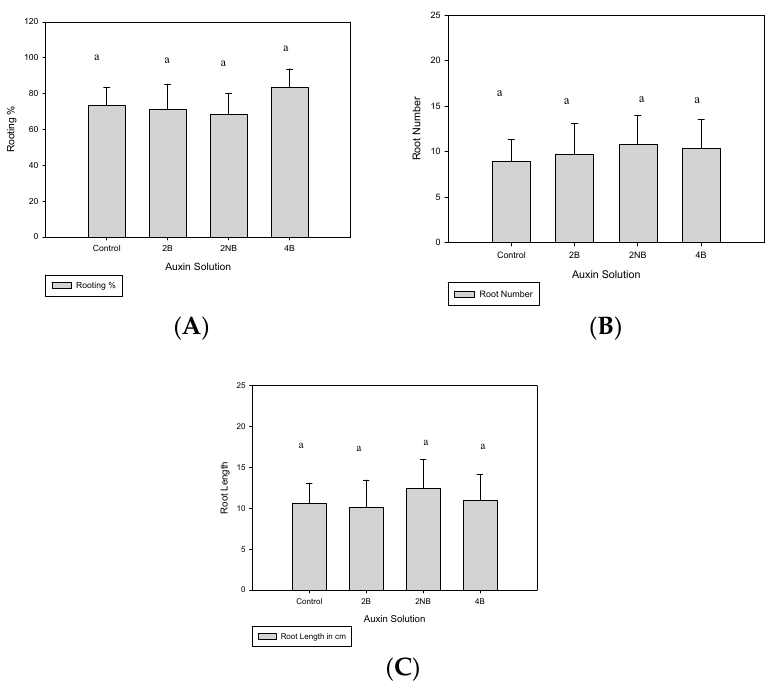
Figure 4. Effect of different auxin solutions and water on rooting ( A ), root length ( B ), and root number ( C ) of Ficus elastica Roxb. Control was water, 2B was 2000 mg·L − 1 IBA (Indole-3-butyric acid), 2NB was 2000 mg·L − 1 IBA + 2000 mg·L − 1 NAA (1-Naphthaleneacetic acid), and 4B was 4000 mg·L − 1 IBA. a There was no significant variation at p ≤ 0.05 by the least significant difference (LSD) test among the auxin treatments.